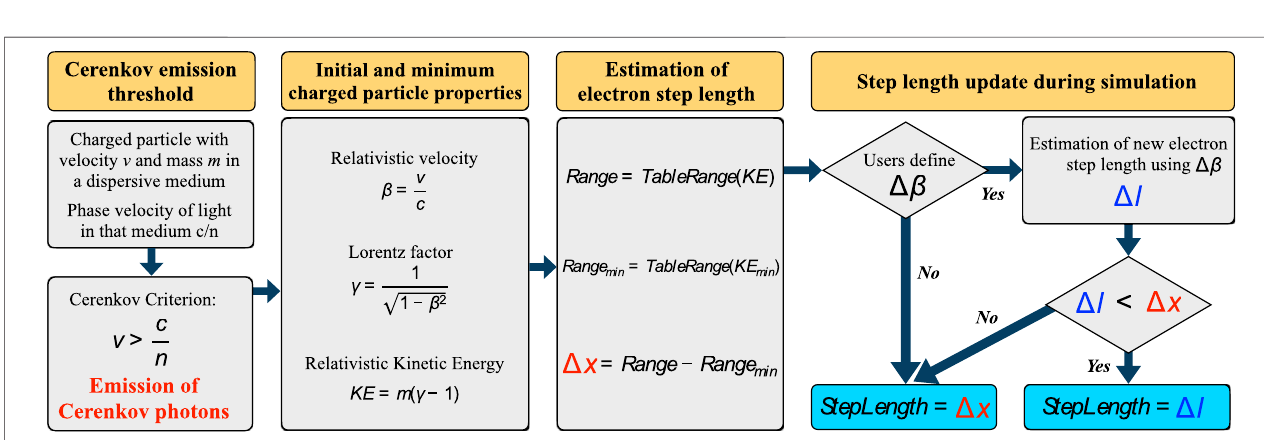
Frontiers in Physics |